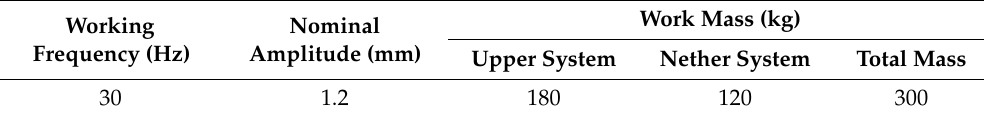
Table 6. The vibration parameters of vertical-vibration-testing machine